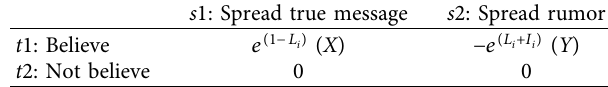
Table 2: Benefit matrix when ordinary nodes receive